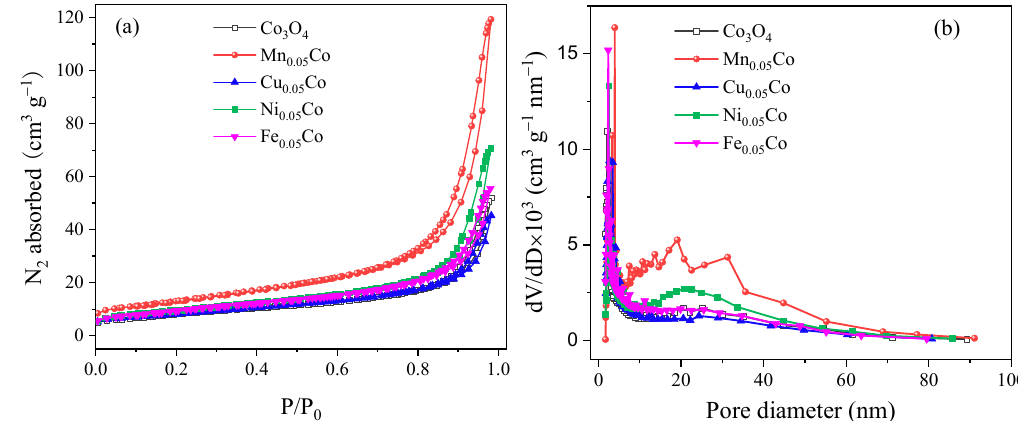
Figure 3. ( a ) N 2 adsorption–desorption isotherms and ( b ) BJH pore size distribution curves of the Co 3 O 4 and M 0.05 Co catalysts.